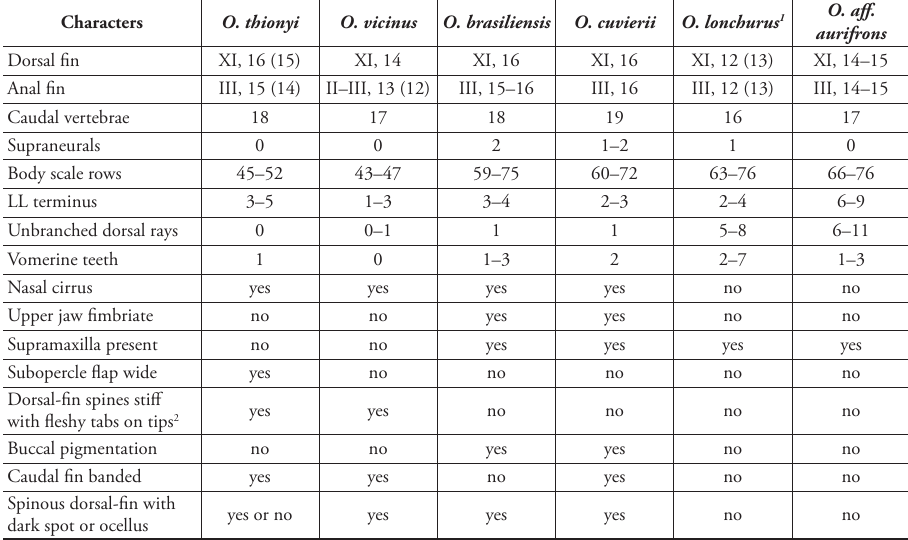
Table 1. Summary of selected characters in Brazilian species of Opistognathus . Exceptional values in